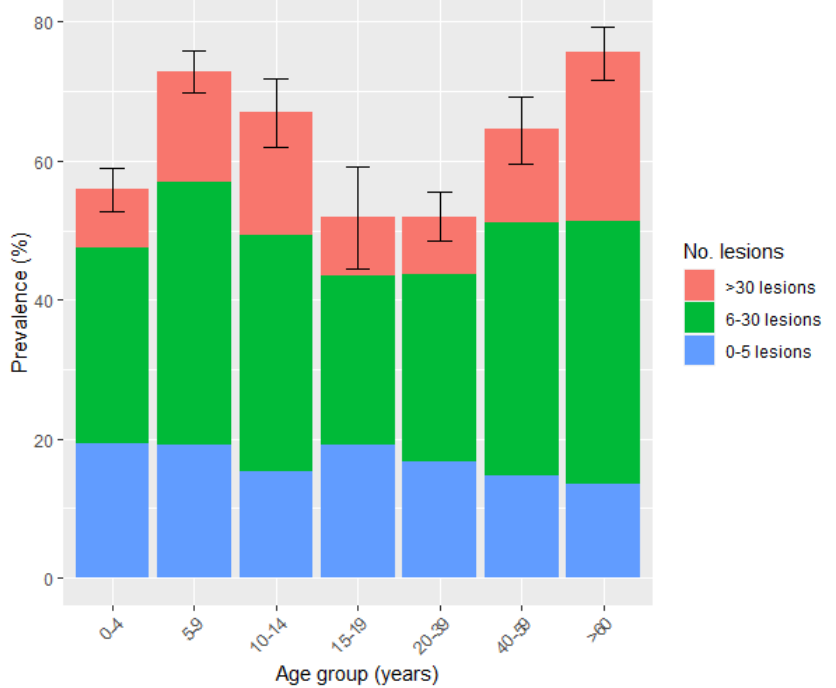
Figure 4. Age-specific prevalence and intensity of human tungiasis. Error bars represent a 95% confidence interval ( n = 4035).